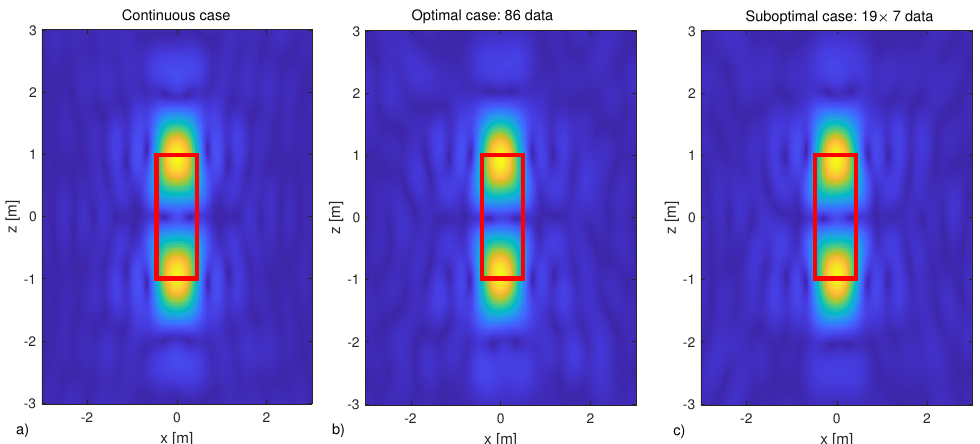
Figure 8. Normalized reconstruction of a 1 m × 2 m rectangular scatterer centered in ( 0,0 ) m. The scattering scenario is ID = [ − 3 λ max ,3 λ max ] × [ − 3 λ max ,3 λ max ] , Ω o = [ − π In panel ( a ), the reconstruction is obtained by taking continuously the measurements, in panels ( b , c ) measurements are collected in optimal and suboptimal grids, respectively. The red lines border the actual scatterer shape. SNR = 20 dB.